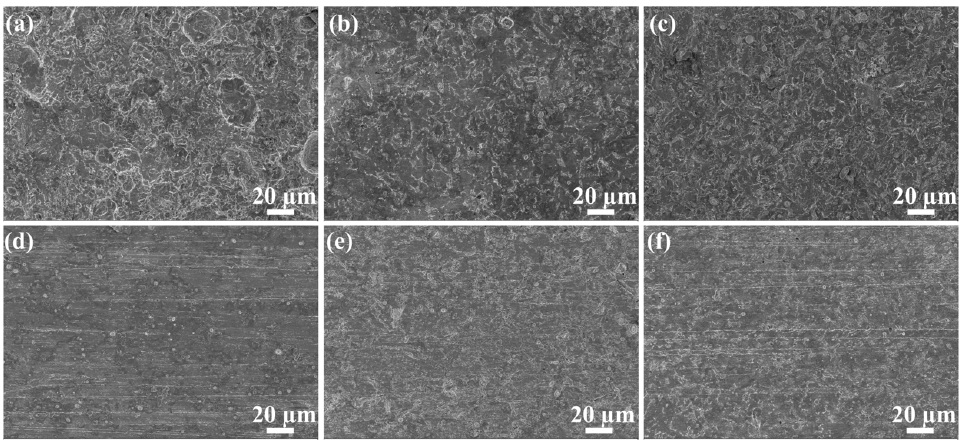
Figure 12. SEM micrographs of the L80 steel surface immersed in test solutions for 168 h: ( a ) pH 3 uninhibited solution, ( b ) pH 7 uninhibited solution, ( c ) pH 11 uninhibited solution, ( d ) pH 3 solution with OIM@PAM , ( e ) pH 7 solution with OIM@PAM and ( f ) pH 11 solution with OIM@PAM .